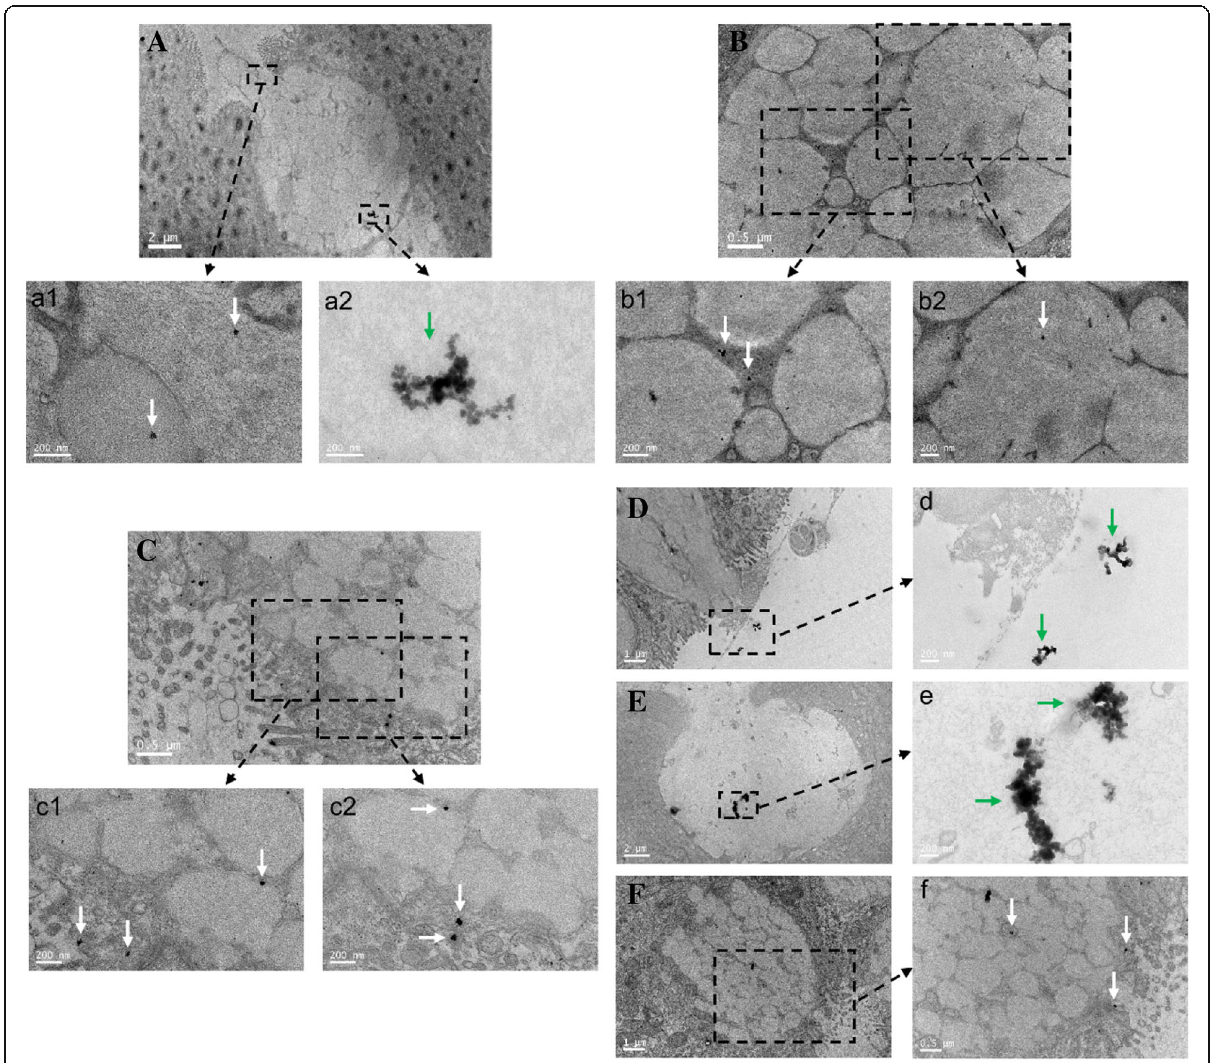
Fig. 4 Distribution of triangular silver nanoplates in intestinal GCs of mice with CBD ligation. The CBD ligation mice group was treated with triangular silver nanoplates injected via tail vein 7 days after ligation. Intestinal GCs of different intestinal tissues. A Duodenum, triangular silver nanoplates were shown in an aggregation mode (green arrow), while some triangular sliver nanoplates were in a dispersion mode (white arrows). B Jejunum, triangular silver nanoplates located at the intestinal GC (white arrows). C Ileum and some triangular silver nanoplates were excreted out, while some were still inside. D Colon, some triangular silver nanoplates were secreted out and into the gut. E , F Rectum, some triangular silver nanoplates were ready to excrete out (dispersion mode, white arrows), while others were still inside (aggregation mode, white